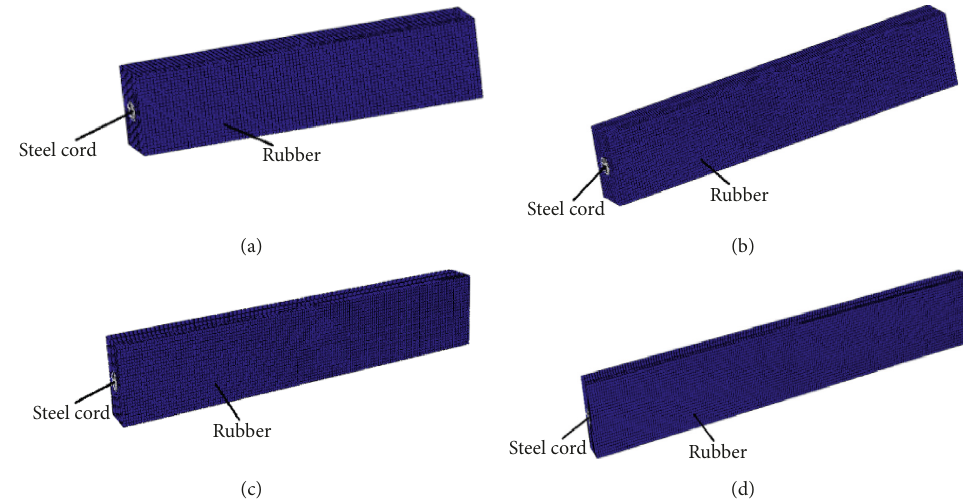
Figure 3: Finite element model of the single steel cord conveyor belt: (a) 50.0 mm; (b) 70.0mm; (c) 80.0mm; (d) 100.0mm.